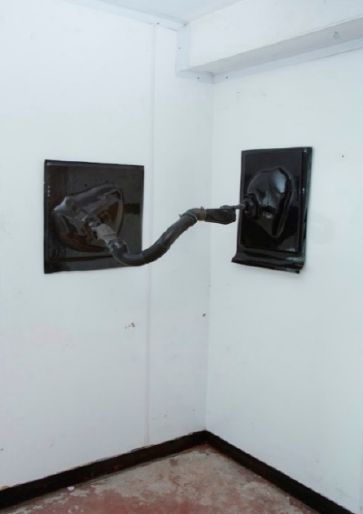
Figure 10. Matthias. 2016. Both Respirator featured in S-O-T Body Repairs exhibition.